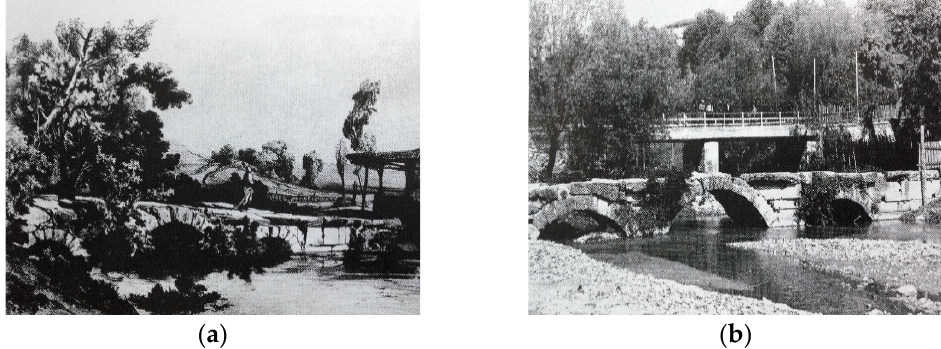
Figure 4. Case study bridge images: ( a ) Watercolor painting adapted from [38]; ( b ) Photograph adapted from [39].